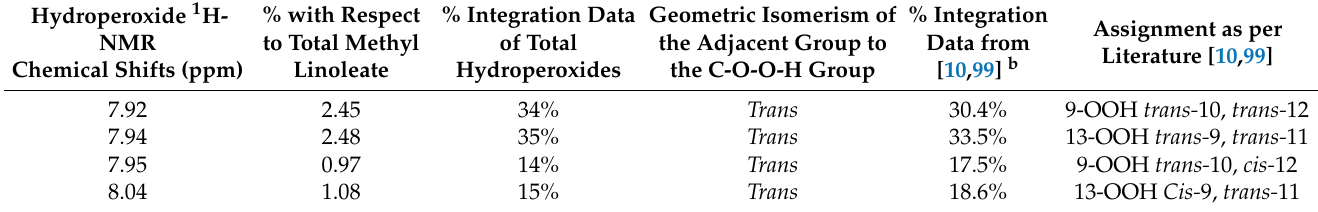
Figure 40. Selected region of 800 MHz 1 H– 13 C HMBC NMR spectrum of 45 mg of methyl linoleate in CDCl 3 subjected to heating at 70 ◦ C for 8 h. Number of scans, 32; number of increments, 256; total experimental time, 11 h 46 min [137]. Table 7. Comparison of NMR quantification data a of hydroperoxides produced during oxidation of methyl linoleate heated at 70 ◦ C for 8 h [137] and with the reported literature for chromatographically isolated hydroxyperoxides [4,6].